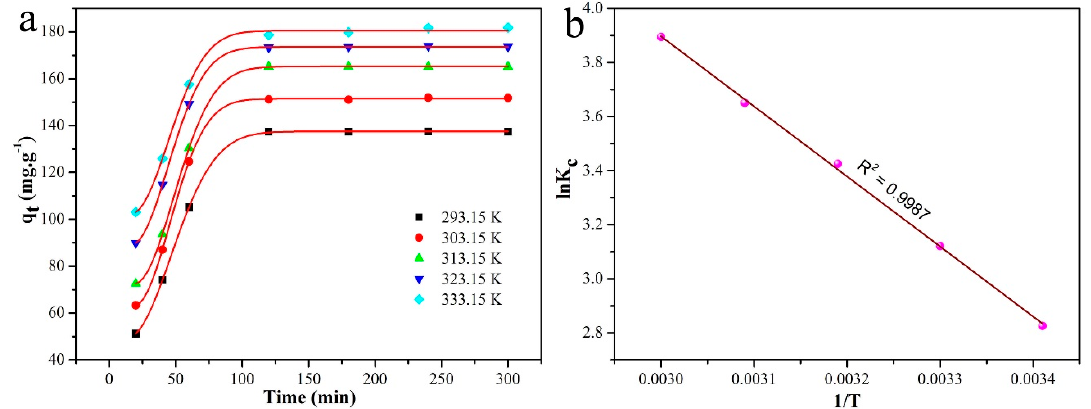
Figure 10. Adsorption curves measured at different temperatures (a) and the plot of ln Kc versus 1/T for MnO-4 (b).